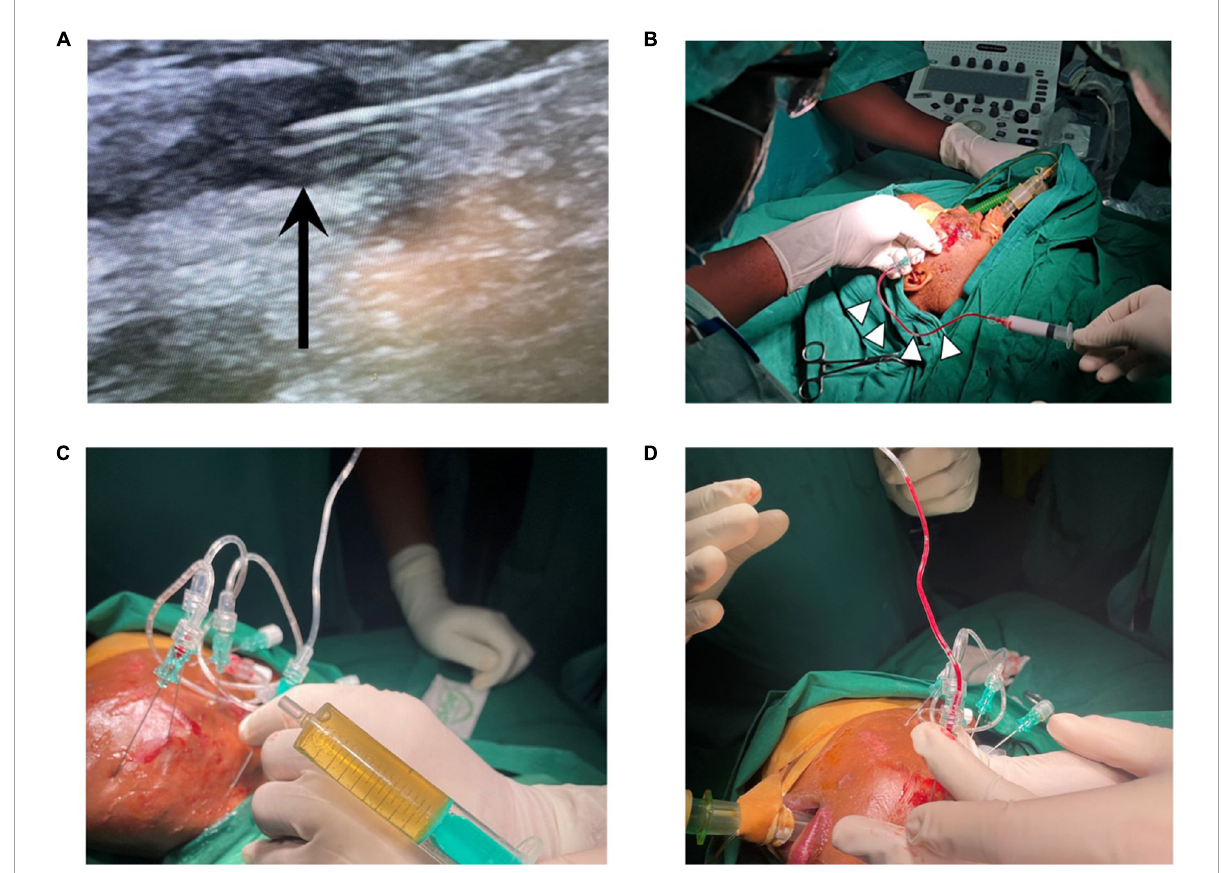
FIGURE2 (A) Ultrasound-guided needle placement in dysplastic veins of a VM, black arrow points at needle tip. (B) Aspiration of blood (white arrow heads) confirms needle position within dysplastic VM vessels prior to sclerotherapy with polidocanol foam. (C) Aspiration of lymph fluid and (D) aspiration of blood in a mixed-type lymphatic and venous malformation, treatment with bleomycin (for lymphatic cysts) and polidocanol (for venous components). VM = venous malformation.